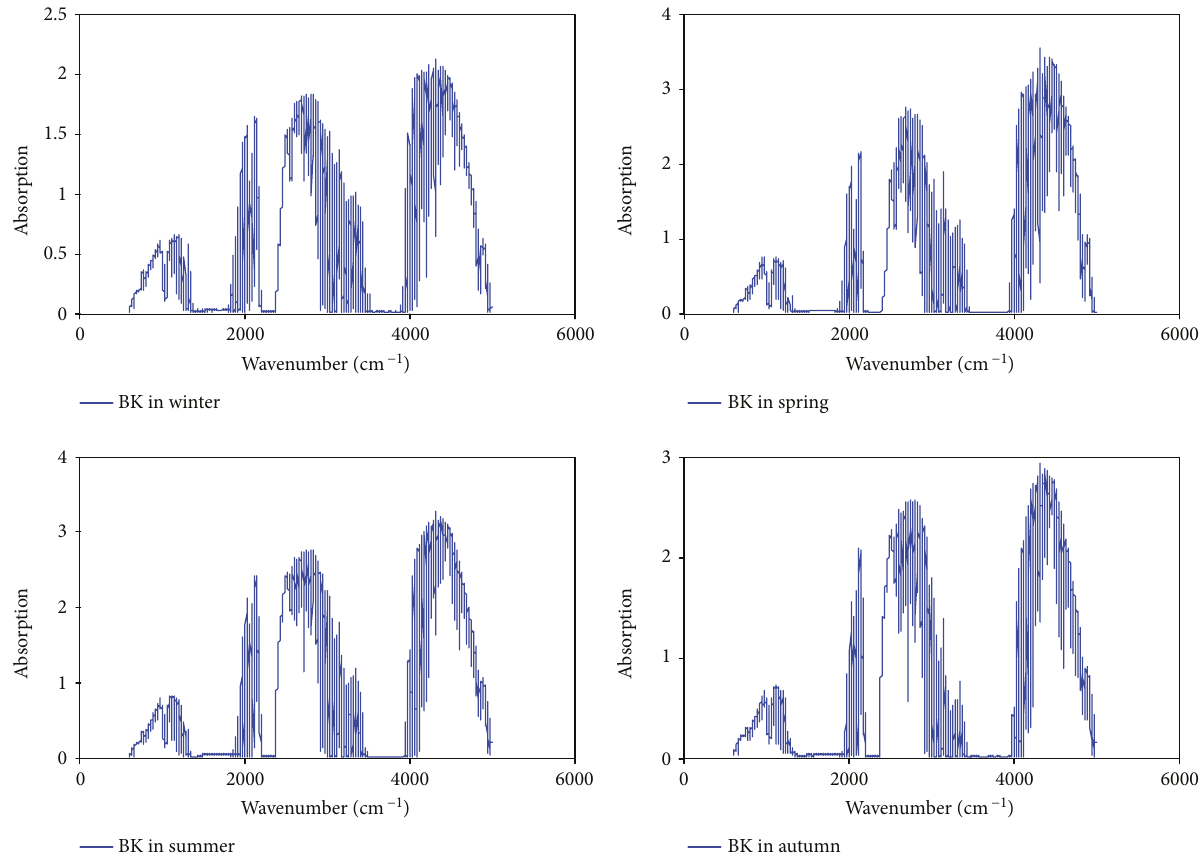
Figure 7: Background spectrum at four seasons. Table 2: Target gases and their inversion